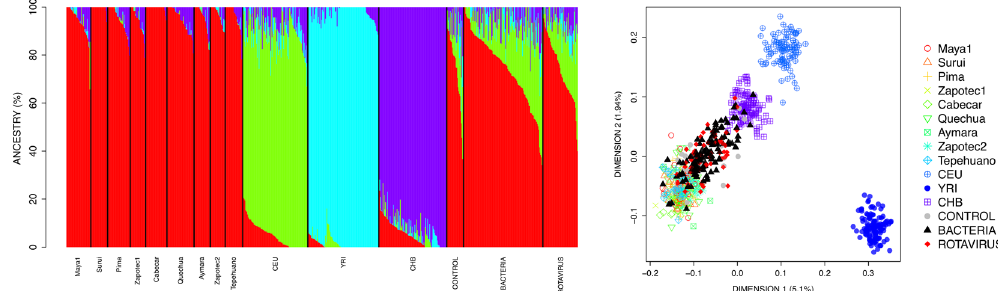
Figure 1. Ancestry analysis of RNA samples based on SNP data. ( A ) Barplot of maximum likelihood estimations of individual ancestries, indicating that most patients have a main Native American ancestry, while European ancestry is present in a few of them with values ranging from 0% to 57.7%. ( B ) MDS plot of pairwise individual IBS values showing that the genome profile of patients and controls (labeled in the figure as control, bacteria and rotavirus) falls close to the Native America cluster (identified by several population samples of Native American ethnic origin), and some of the samples slightly displaced towards the European pole represented by CEU in Dimensions 1 and 2.